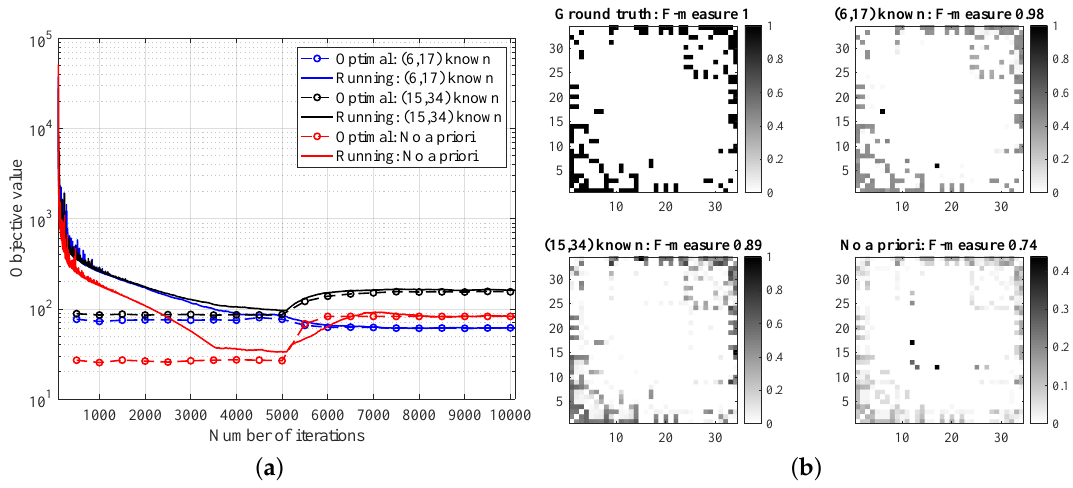
Figure 2. Recovery of Zachary’s karate club graph with N = 34 nodes. ( a ) Evolution of the objective values for the online and batch estimators in inferring a karate club. ( b ) Ground-truth adjacency matrix and corresponding estimates after 5000 time steps, for different prior connectivity information